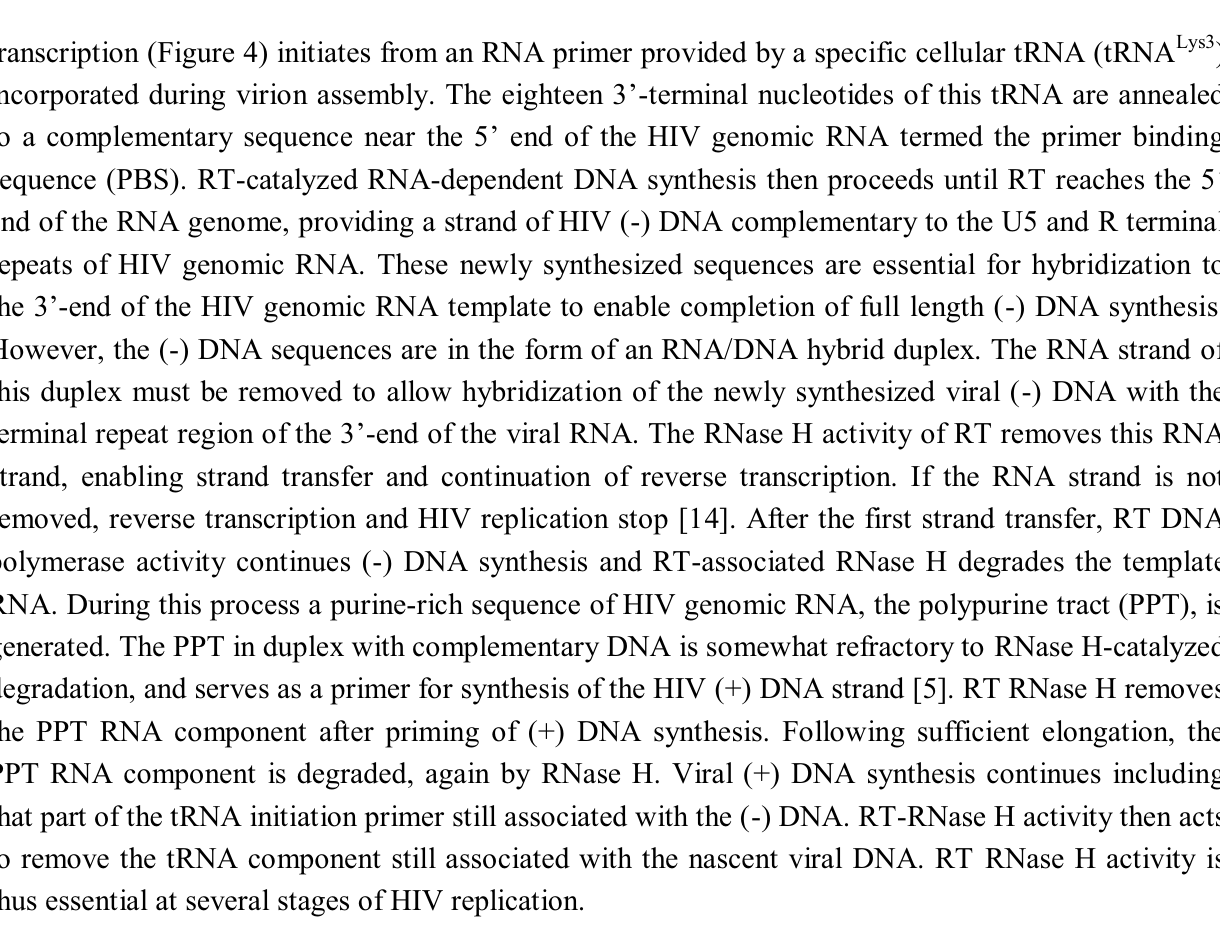
Figure 4. Schematic of the stages of reverse transcription. Stages where RT-RNase H (cid:73)(cid:88)(cid:81)(cid:70)(cid:87)(cid:76)(cid:82)(cid:81)(cid:86)(cid:3)(cid:68)(cid:85)(cid:72)(cid:3)(cid:76)(cid:81)(cid:71)(cid:76)(cid:70)(cid:68)(cid:87)(cid:72)(cid:71)(cid:3)(cid:69)(cid:92)(cid:3)(cid:179)(cid:53)(cid:49)(cid:68)(cid:86)(cid:72)(cid:3)(cid:43)(cid:180)(cid:3)(cid:68)(cid:81)(cid:71)(cid:3)(cid:68)(cid:3)(cid:71)(cid:68)(cid:86)(cid:75)(cid:72)(cid:71)(cid:3)(cid:79)(cid:76)(cid:81)(cid:72)(cid:3)(cid:71)(cid:72)(cid:81)(cid:82)(cid:87)(cid:76)(cid:81)(cid:74)(cid:3)(cid:53)(cid:49)(cid:36)(cid:3)(cid:75)(cid:92)(cid:71)(cid:85)(cid:82)(cid:79)(cid:92)(cid:86)(cid:76)(cid:86)(cid:17)(cid:3)(cid:39)(cid:72)(cid:87)(cid:68)(cid:76)(cid:79)(cid:86)(cid:3) are in the